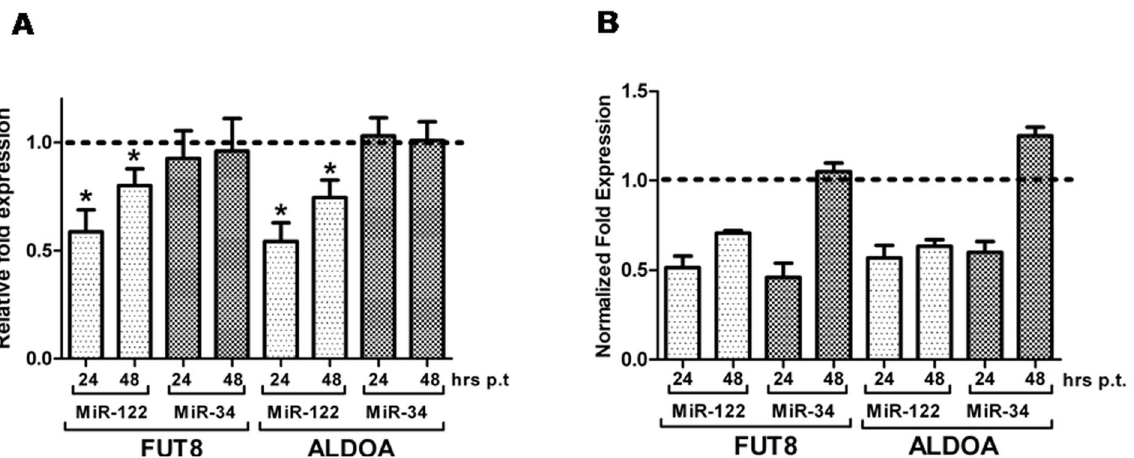
Figure 2. Effects of miRNA transfection HepG2 cells. Cells were transfected with either the AllStar siRNA negative control, miR-122 mimic or miR-34a mimic in 12 well plates. After 24 and 48 hours total RNA and proteins were extracted. (A) mRNA levels were determined by qRT-PCR. Data were reported as relative fold expression compared to controls (indicated by the dotted line) and they were means 6 SD of seven independent experiments. (B) Total proteins of HepG2 were recovered after 24 and 48 hours post-transfection of AllStar siRNA negative control, miR-122 or miR- 34a mimics. After SDS-PAGE separation and blotting, the membranes were probed sequentially using antibodies against FUT8, ALDOA and b -Actin. Band intensities were measured by densitometry and the values obtained for FUT8 and ALDOA were normalized using b -Actin. Data are expressed as normalized levels relative to the cells transfected with the negative control (indicated by the dotted line). Data were obtained from three independent experiments. *p , 0.05.